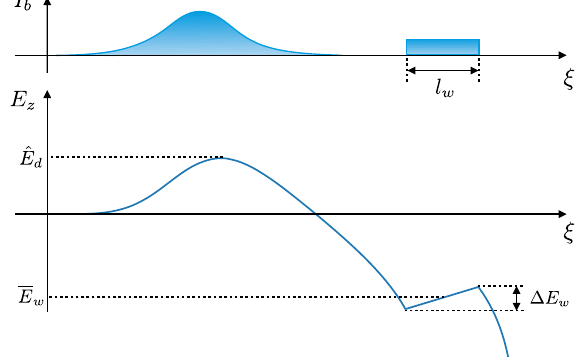
FIG. 7. Illustration of the current profiles of a drive and a witness beam pair (top) and resulting longitudinal wakefield structure in a PWFA (bottom). The peak decelerating field within the drive beam region is denoted by accelerating field within the witness beam by beam with flattop current profile and length l w loads the wake in such a way that the longitudinal field varies by Δ E w from head-